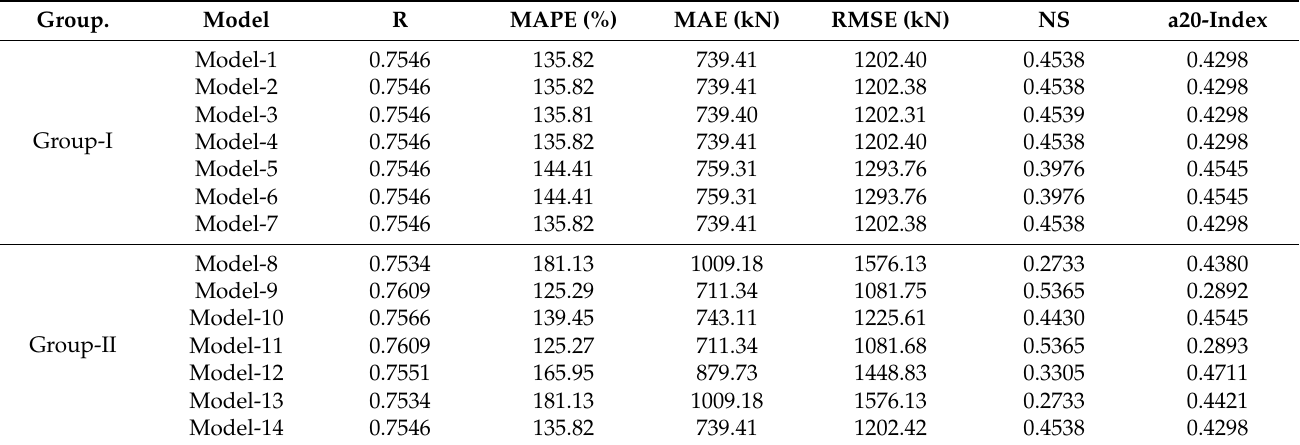
Table 5. Performance matrices of analytical